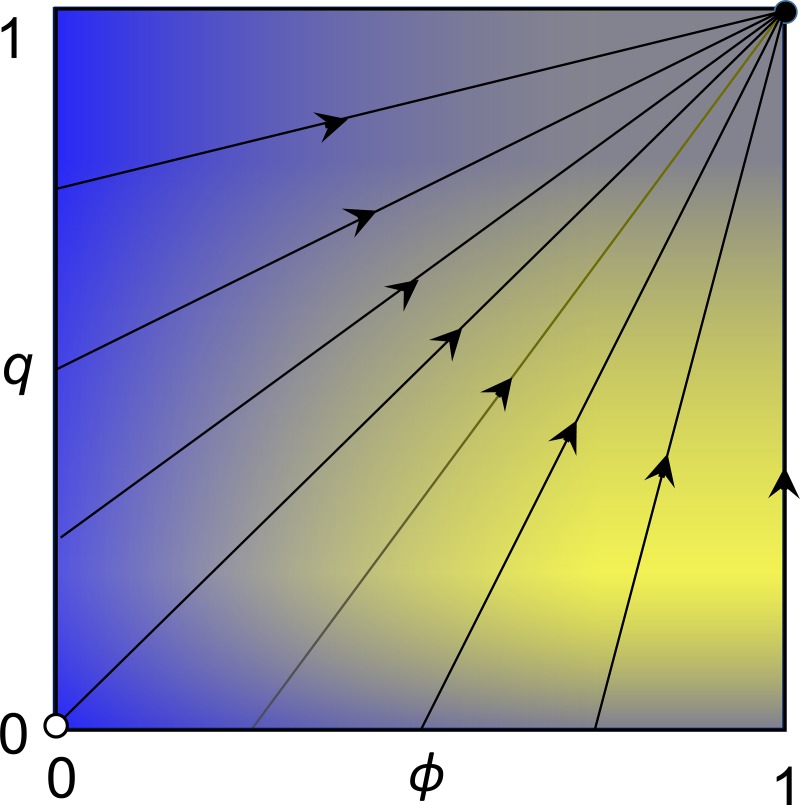
Replicator dynamics.The set of points determined by values of ϕ and q, illustrating the basin of attraction and typical trajectories of the replicator dynamics, with an unstable rest point where ϕ = q = 0 and stable rest point and global attractor at ϕ = q = 1. The shading indicates most rapid change at high values of ϕ and q = 1/3.